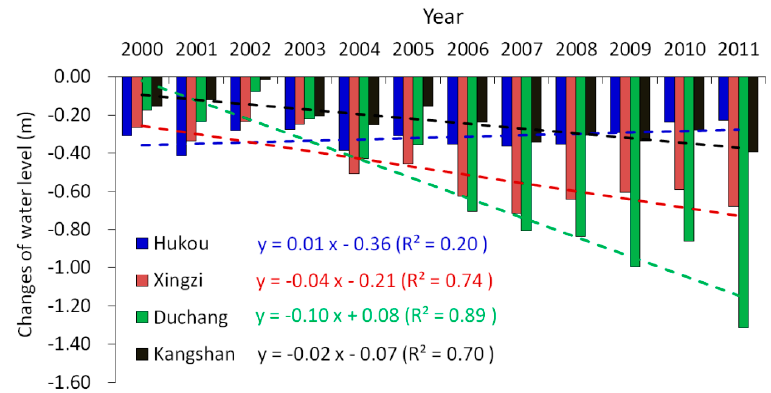
Figure 6. Variation and linear trends of annual water level changes during 2000–2011.